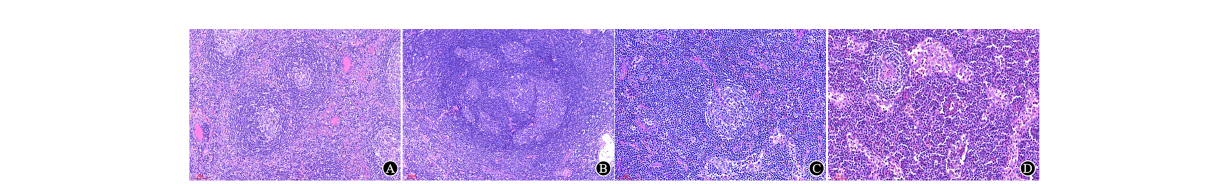
FIGURE 6 Typical Castleman disease. (A) Follicles with atrophic germinal centers and expanded mantle zones, forming a concentric annular structure, with an “ onion-skin ” look (×150); (B) Multiple germinal centers within a single mantle area (×65); (C) A remarkable hyalinized vessel grows into the germinal centers, forming a “ lollipop ” appearance (×200); (D) Sheets of plasma cells are seen in the interfollicular region in PC-type CD